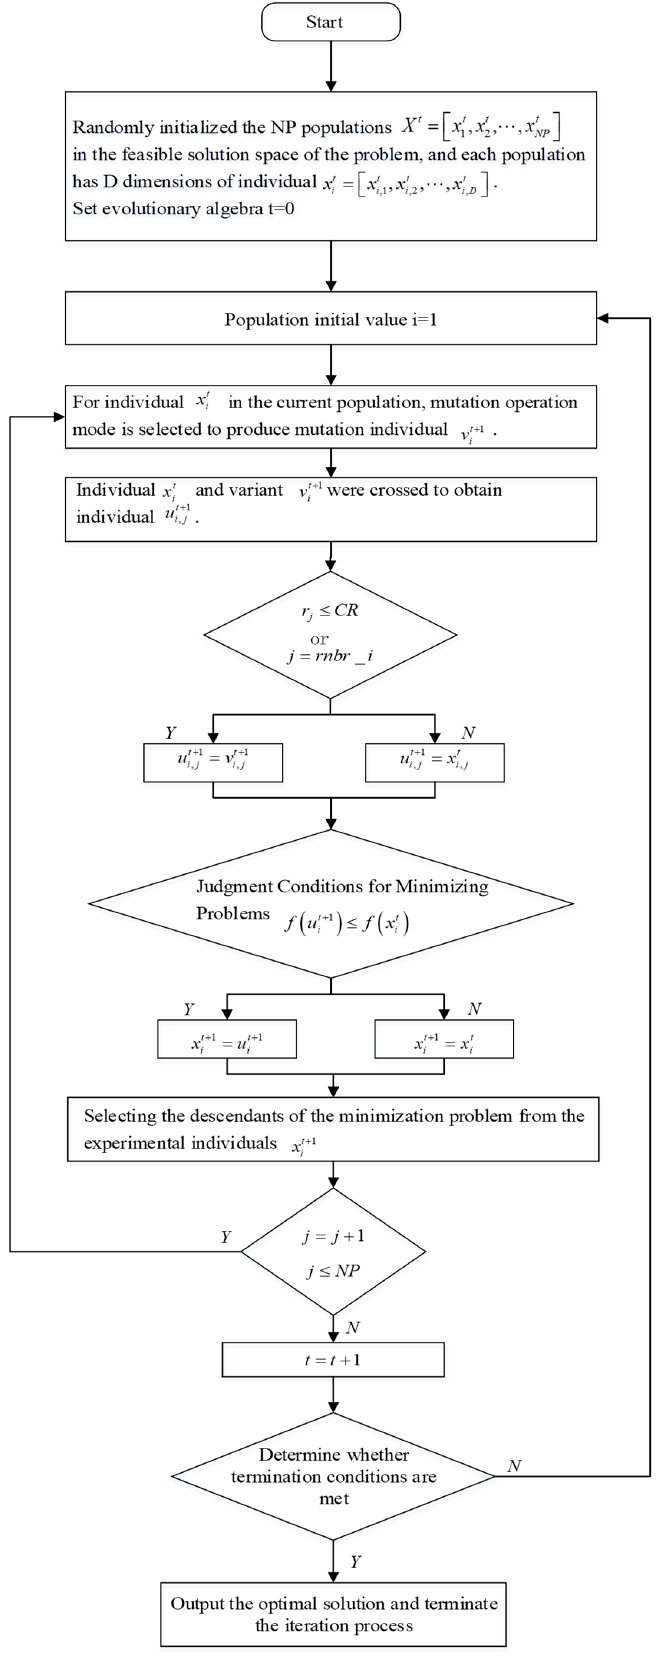
Figure 1. Flow chart of the differential evolution (DE) algorithm.